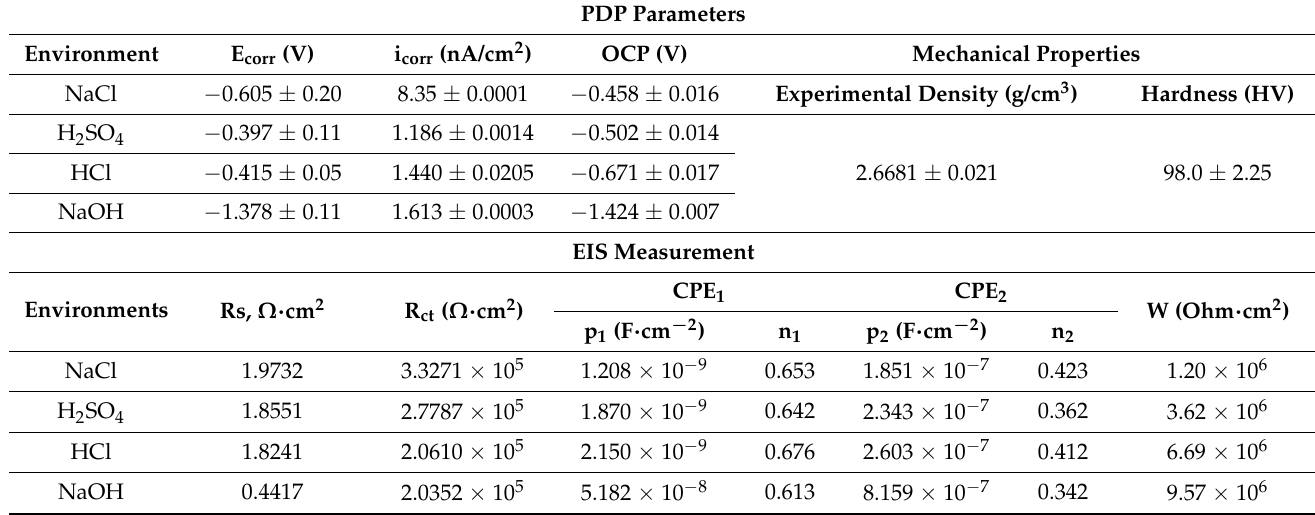
Table 2. PDP and EIS corrosion parameters and mechanical properties of fabricated 17.5% B4C/Al- Mg-Si AMCs in various environments.